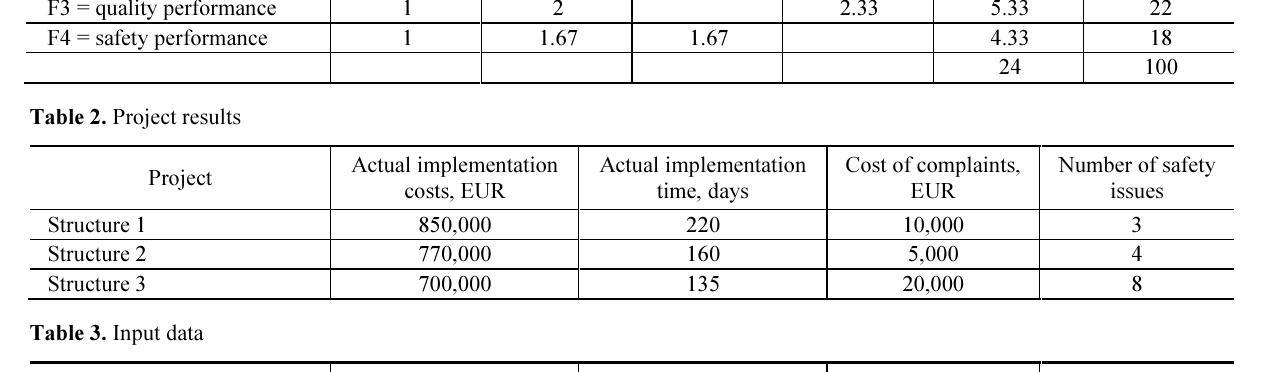
Table 3. Input data Project